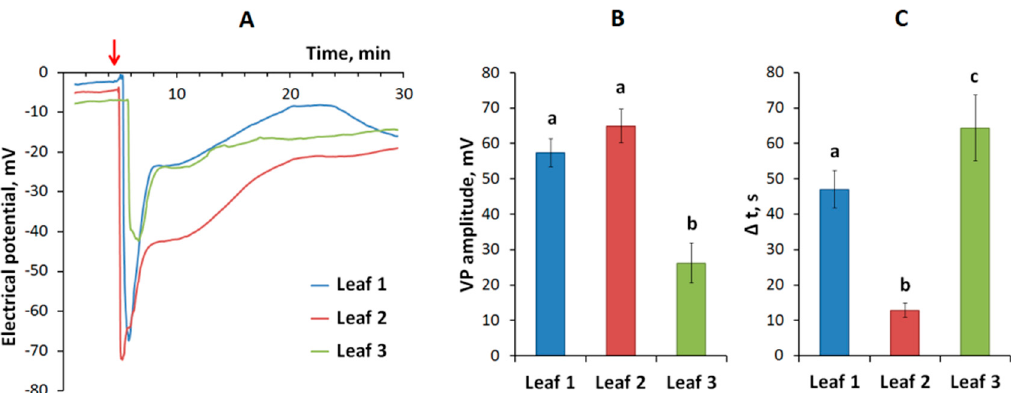
Figure 2. Variation potential (VP) induced by local burning of a pea leaf: ( A ) the typical record of electrical reaction; ( B ) VP amplitude in the first, second and third leaves, located below the stimulated leaf; ( C ) the time interval between stimulation and the VP occurrence in the first, second and third leaves. ( A ): the red arrow indicates the moment of stimulation. ( B ) and ( C ): different letters denote significant differences between columns, p < 0.05.